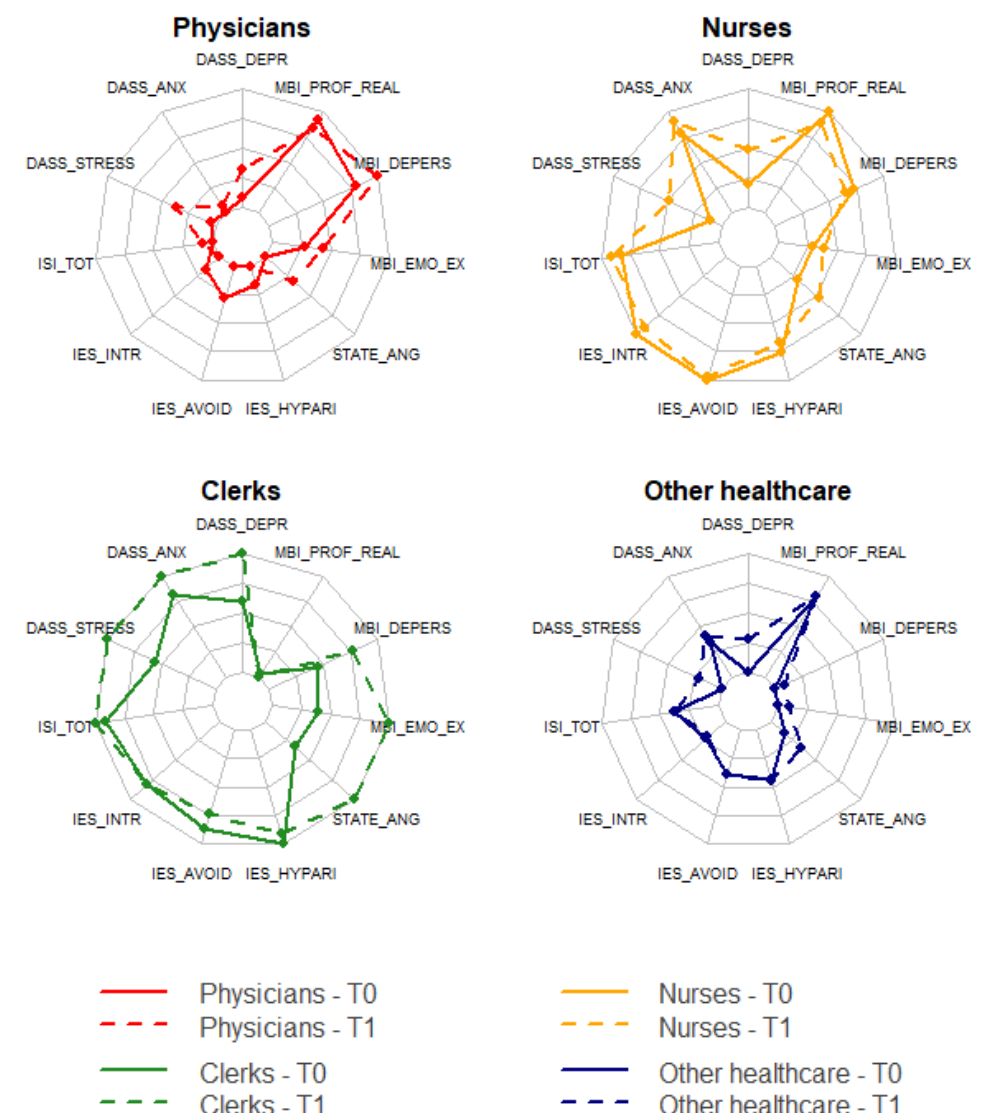
Figure 1. Radar charts displaying average scores of the investigated psychometric variables at T0 and T1, stratified by occupation (Table S1). Out of the 291 participants, 91 were physicians, 97 were nurses, 81 were other healthcare workers, and 22 were clerks. Abbreviation: DASS Depr, Depression Anxiety Stress Scale-Depression; DASS Anx, Depression Anxiety Stress Scale-Anxiety; DASS Stress, Depression Anxiety Stress Scale-Stress; MBI Prof Real, Maslach Burnout Inventory-Professional Realization; MBI Depers, Maslach Burnout Inventory-Depersonalization; MBI Emo Ex, Maslach Burnout Inventory-Emotional Exhaustion; STATE Ang, STATE Anger; IES Hypar, Impact of Event Scale- Hyperarousal; IES Avoid, Impact of Event Scale-Avoidance; IES Intr, Impact of Event Scale- Intrusion; ISI Tot, Insomnia Severity Index Total score.